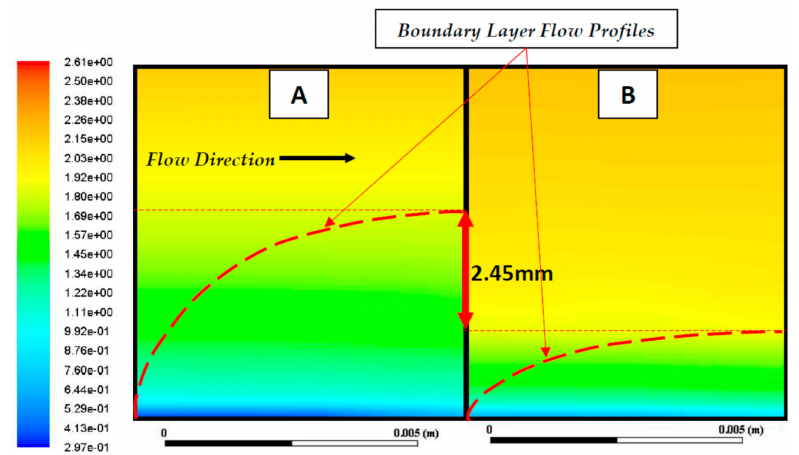
Figure 13. Boundary layer comparison (no bleed vs bleed; configuration ( A , B